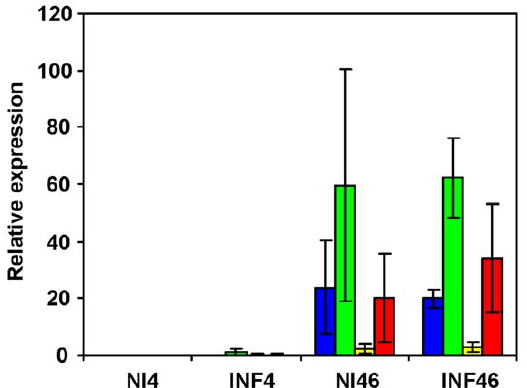
Figure 4. Expression of genes encoding constant parts of immunoglobulins in the cecum of 4- and 46-day-old chickens. NI4 – expression in the cecum of 4-day-old, non-infected chickens, INF4 – expression in the cecum of 4-day-old chickens orally infected with S . Enteritidis on day 1 of life, NI46– expression in the cecum of 46-day-old, non-infected chickens, IFN46– expression in the cecum of 46-day-old